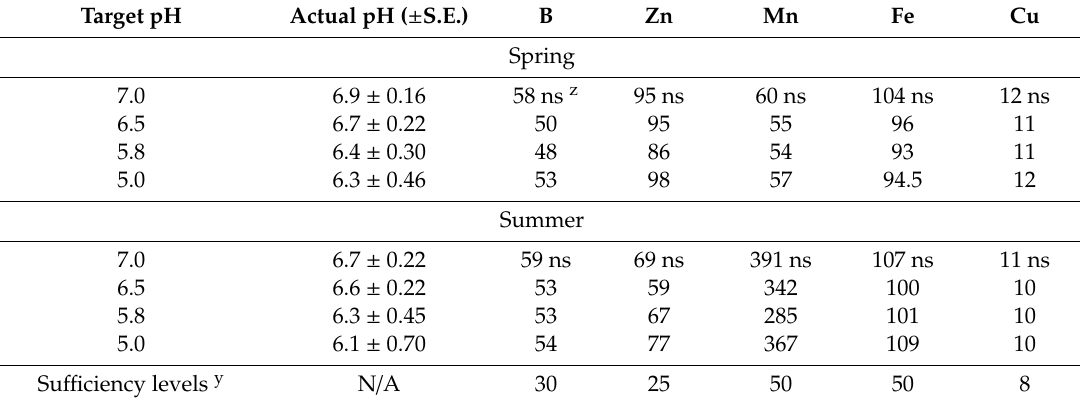
Table 9. End-of-season foliar analysis of micronutrients as percent mg · kg –1 dry matter for aquaponic cucumbers at four pH treatments.